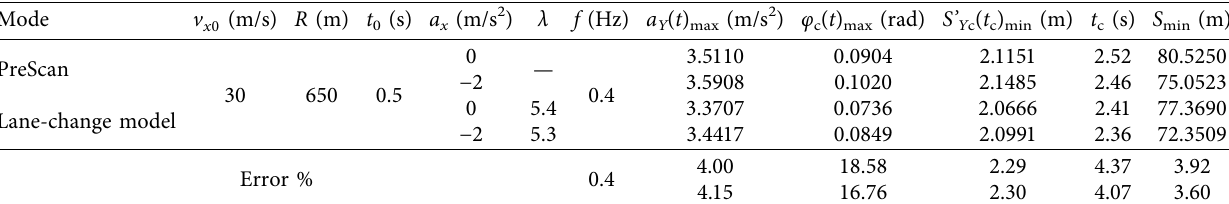
Table 2: Detailed comparison by different simulation